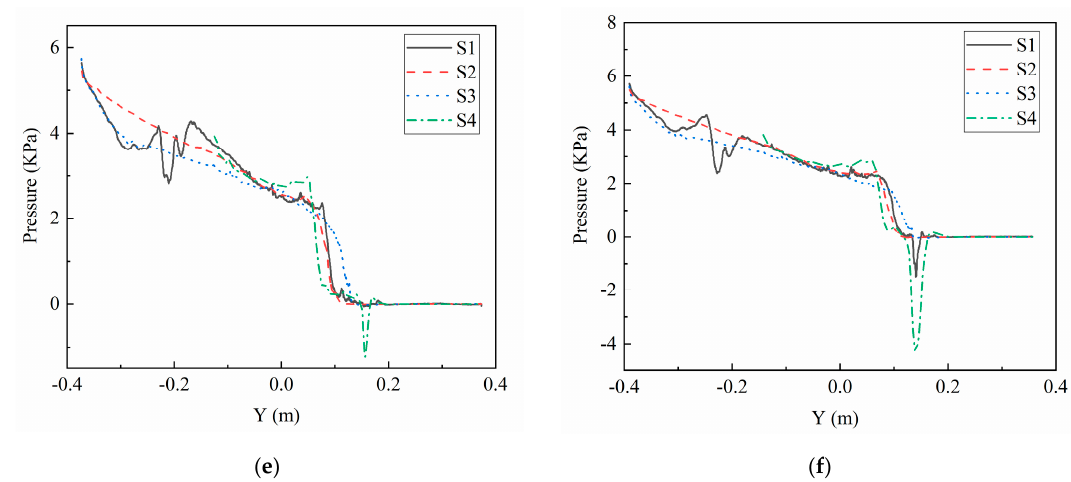
Figure19. Pressuredistributiononthewettedsurfacefordi ff erentsections: ( a )t = 0.225s; ( b ) t = 0.2375 s; Figure 19. Pressure distribution on the wetted surface for different sections: ( a ) t = 0.225 s; ( b ) t = ( c ) t = 0.25 s; ( d ) t = 0.2625 s; ( e ) t = 0.275 s; ( f ) t = 0.2875 s. 0.2375 s; ( c ) t = 0.25 s; ( d ) t = 0.2625 s; ( e ) t = 0.275 s; ( f ) t = 0.2875 s.